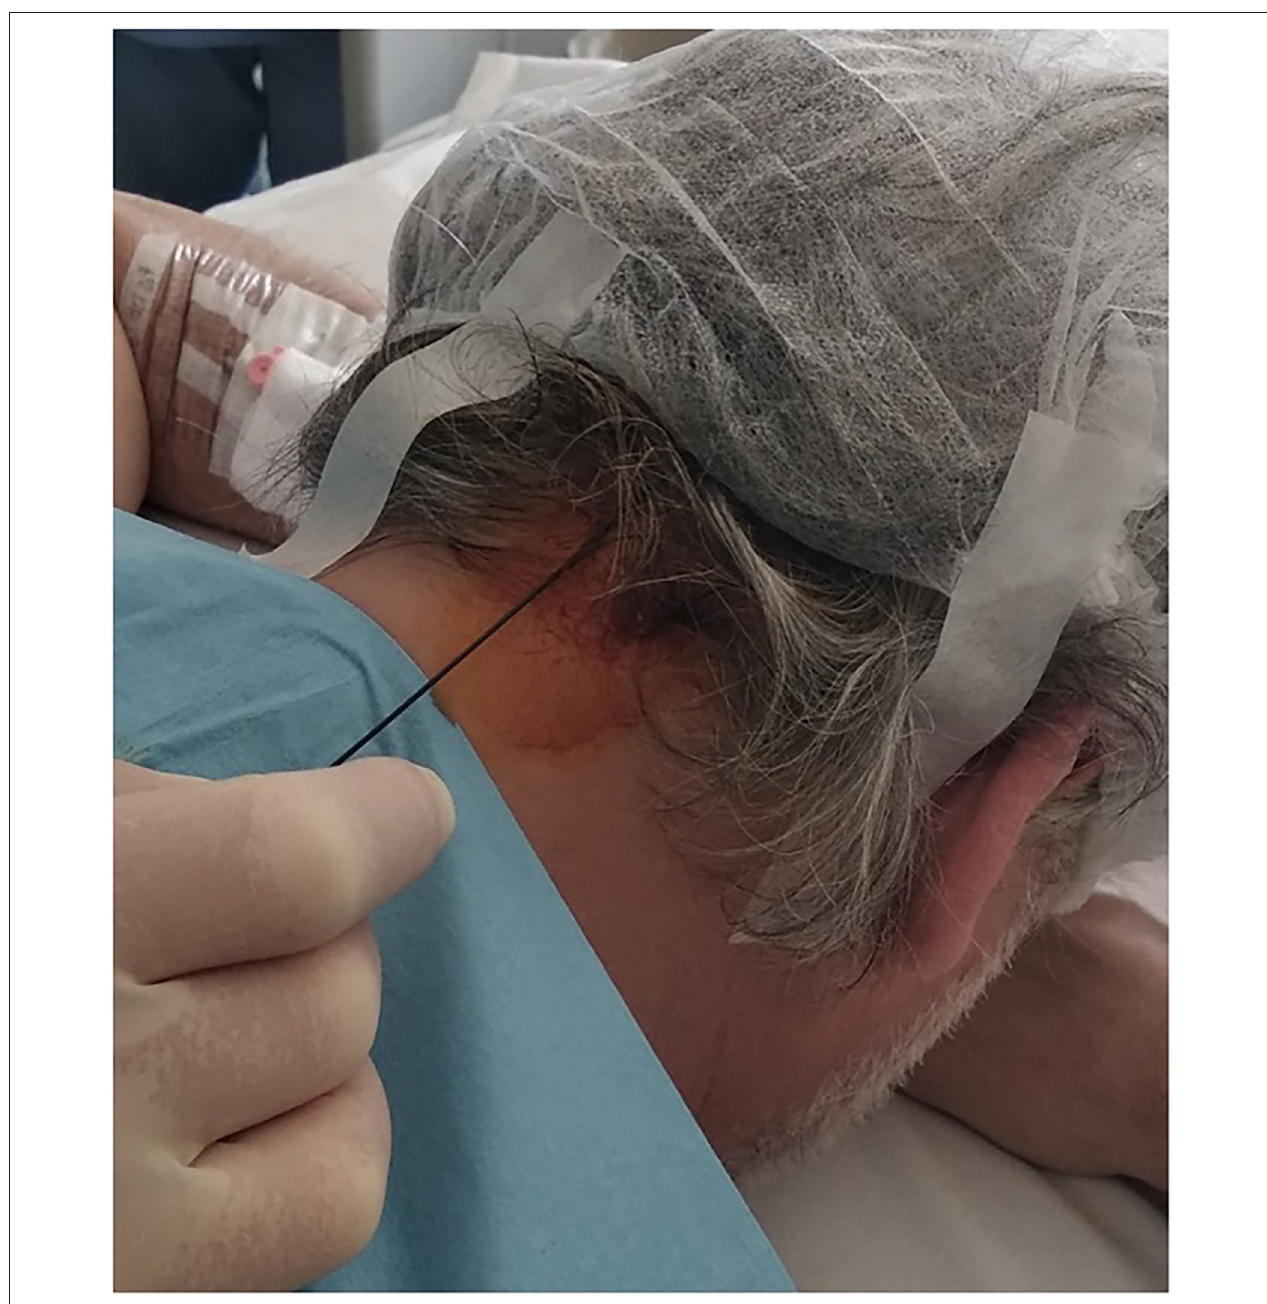
FIGURE 1 | Pulsed Radiofrequency of the